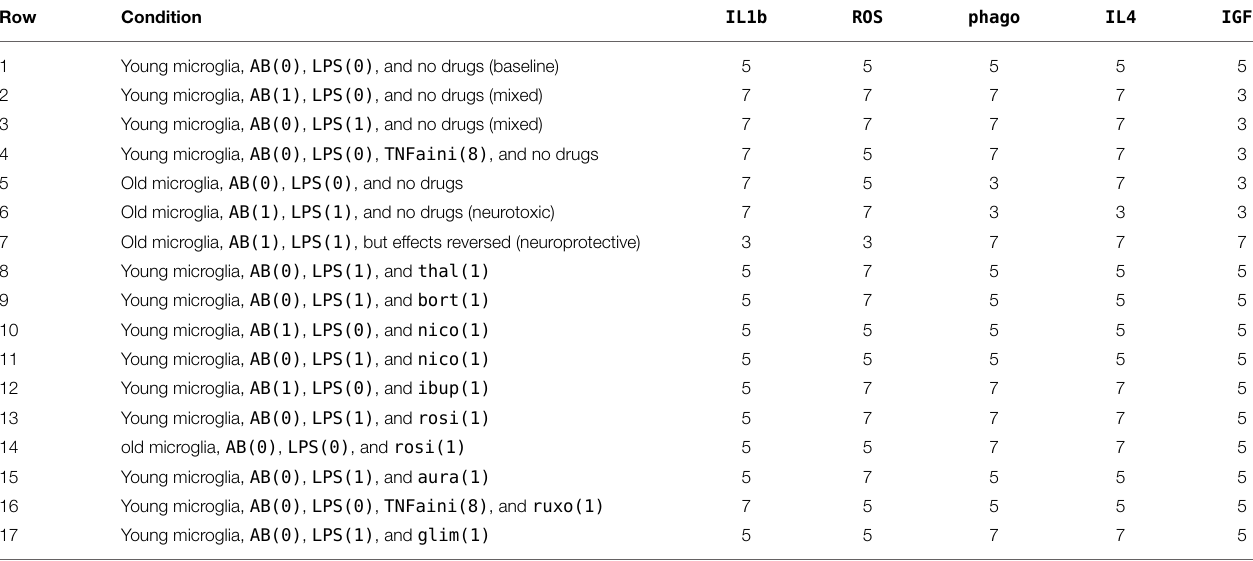
The first seven rows list a set of reference phenotypes with no drugs (including mixed, neurotoxic, and neuroprotective). The following 10 rows list specific phenotypic modifications due to certain drugs administered singly. The abbreviation TNFaini stands for the initial level of TNFa .